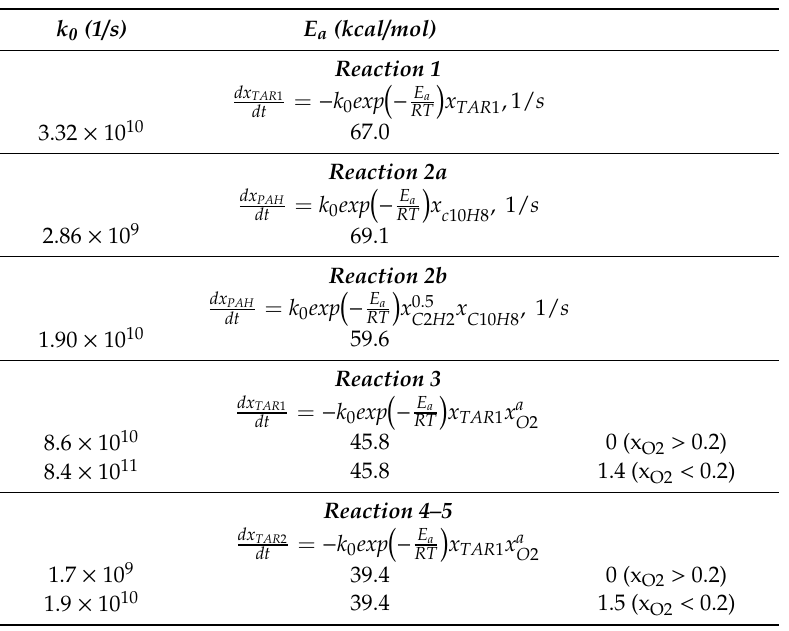
Table 2. Kinetic parameters.